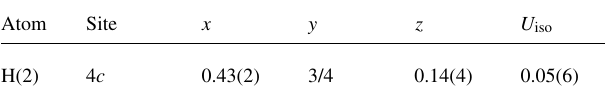
Table 2. Atomic coordinates and displacement parameters (in Å 2 )